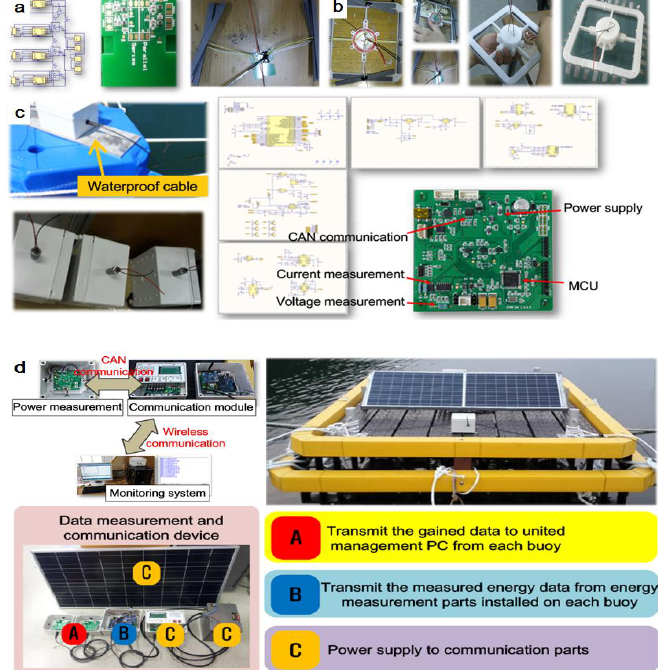
Figure 4. Harvesting energy module: ( a ) rectifying electricity collector connected in parallel to four IPMC-covered electrodes inside a cell, ( b ) total process of fabrication and assembly for a cell, ( c ) the connecting device, and ( d ) the main buoy and the components of an electricity